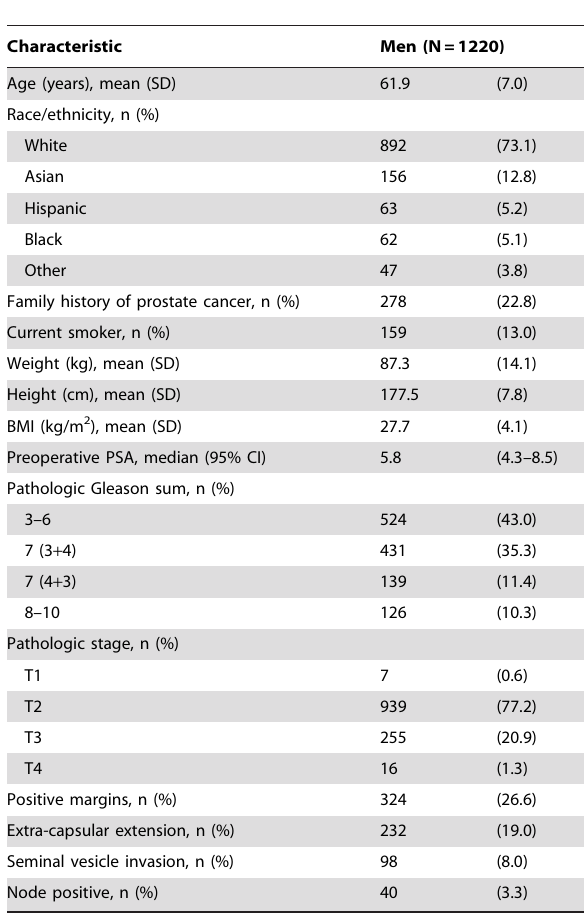
Table 2. Clinical and pathologic tumor characteristics according to